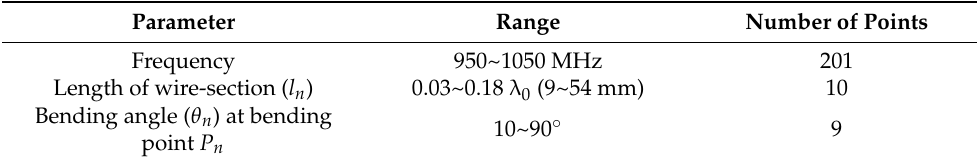
Table 2. Conditions of design parameters and interesting frequency for training data acquisition.